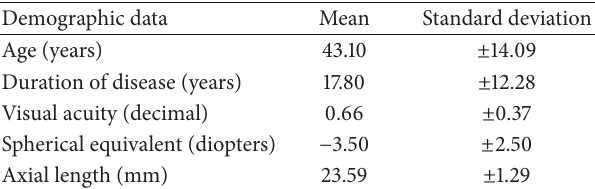
Table 2: Demographic